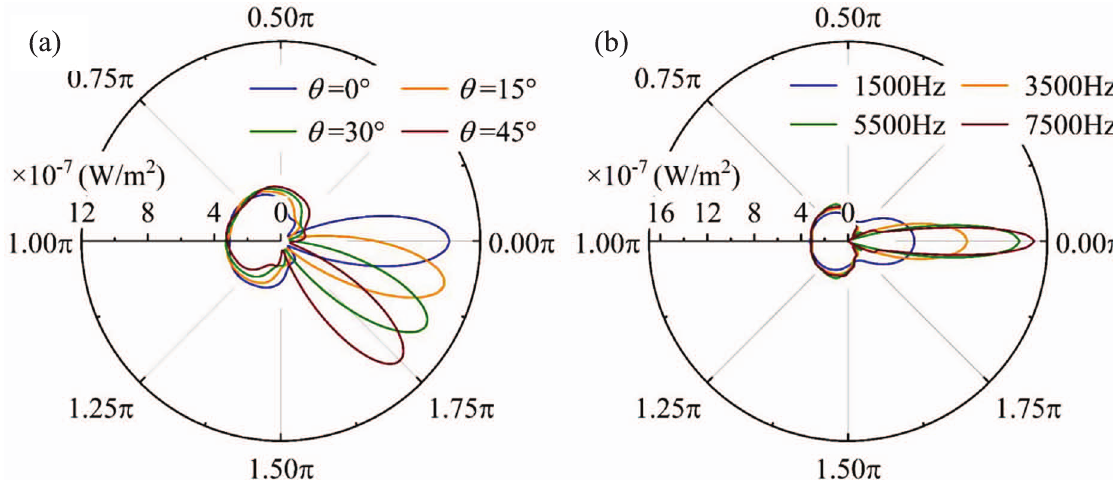
Figure 5. Wave intensity of acoustic wave focusing beam with different incident angles (a) and frequencies (b).